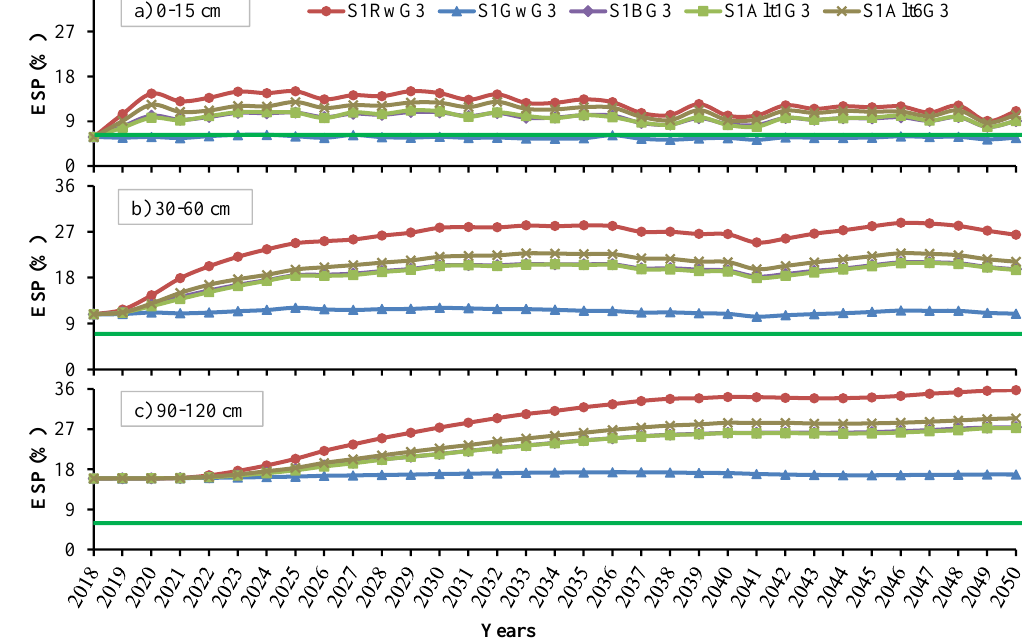
Figure 4. Impact of different water qualities (recycled water, RW; good water, GW; blending RW and GW in a 1:1 ratio, B; RW and GW used in monthly cycles, Alt1; and RW and GW used in half-yearly cycles, Alt6) and annual gypsum applications of 8.6 t/ha (G3) on annual ESP for calcareous soil (S1) under wine grape cultivation.